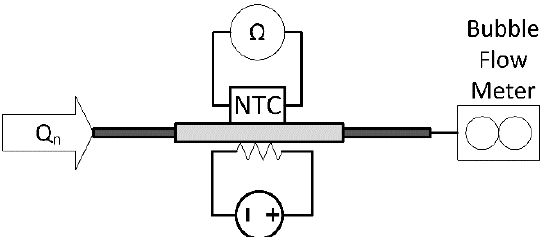
Figure 5. Schematic of the flow sensor and the calibration setup. The flow sensor consists of a 38 Ω heating resistor and a NTC soldered onto hypodermic needle. An electronic circuit controls the heating power to keep the NTC resistance at same values as a reference